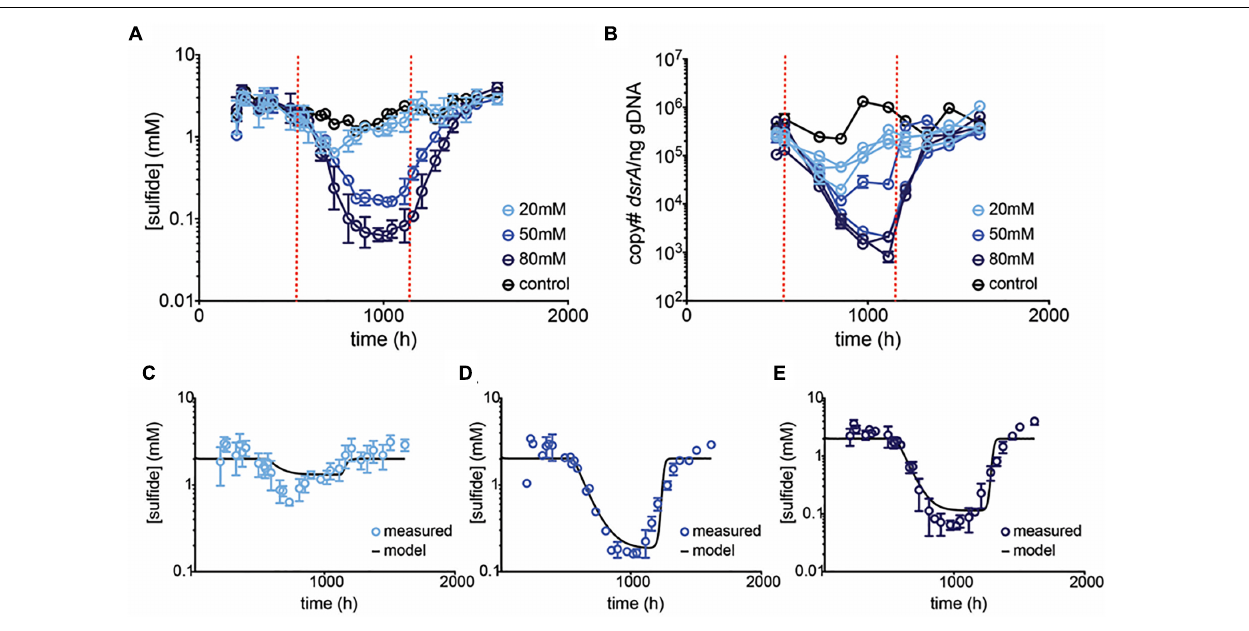
( p = 0.4 for 20 mM 539–1114 h vs. control at all